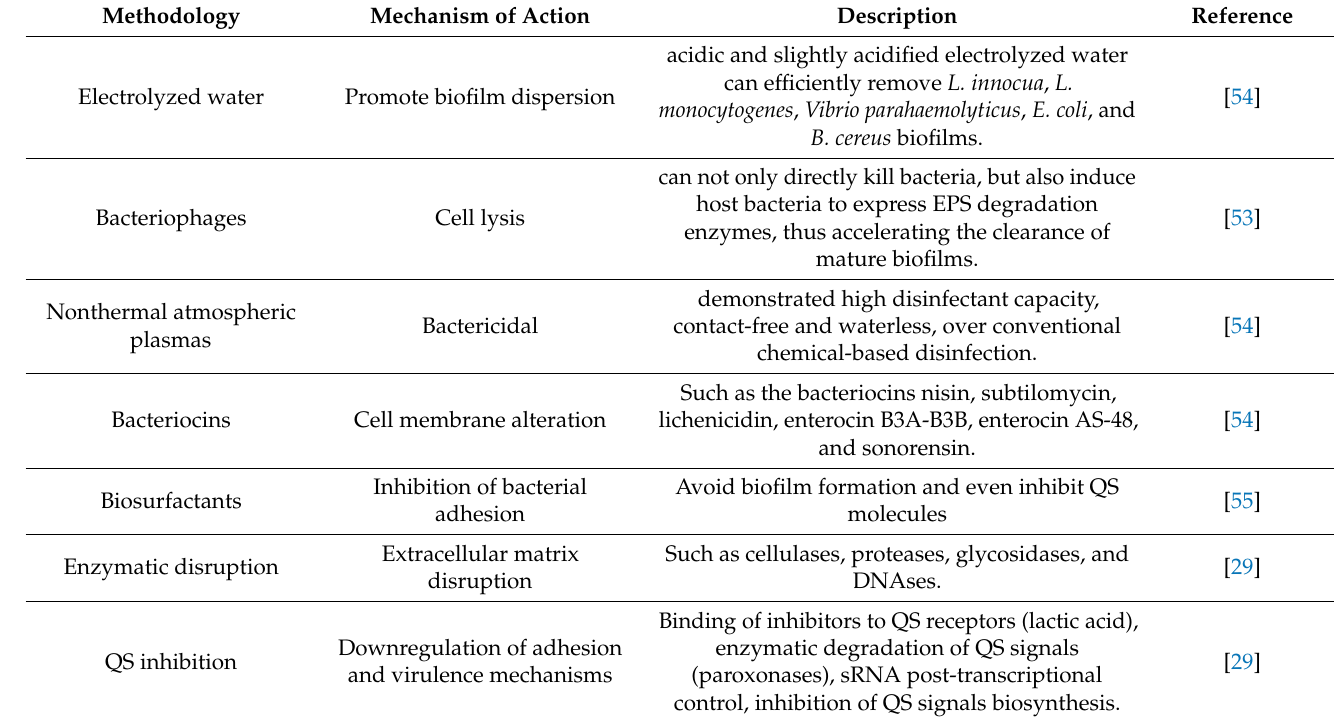
Table 2. Several novel biofilm eliminations and control methods are used in the food industry.